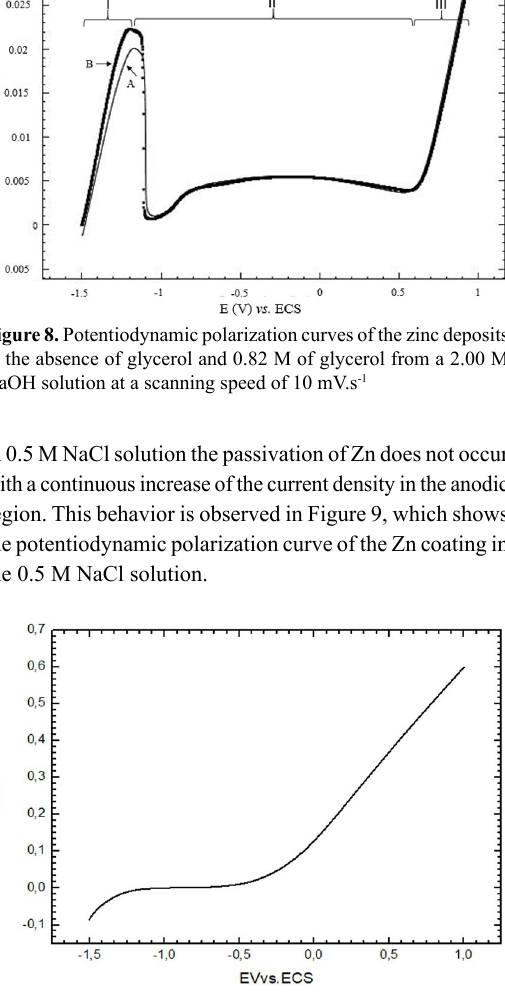
Figure 9. Potentiodynamic polarization curves of the zinc deposits in the absence of glycerol from a 0.5 M NaCl solution at a scanning speed of 10 mV.s